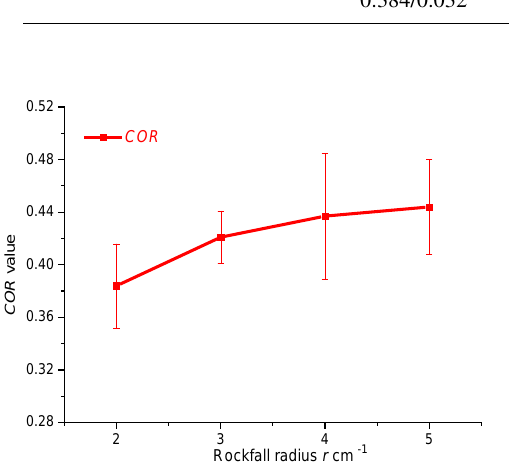
Figure 5. The COR (mean ± SD) of block collisions with the plate (error bars: 1 standard